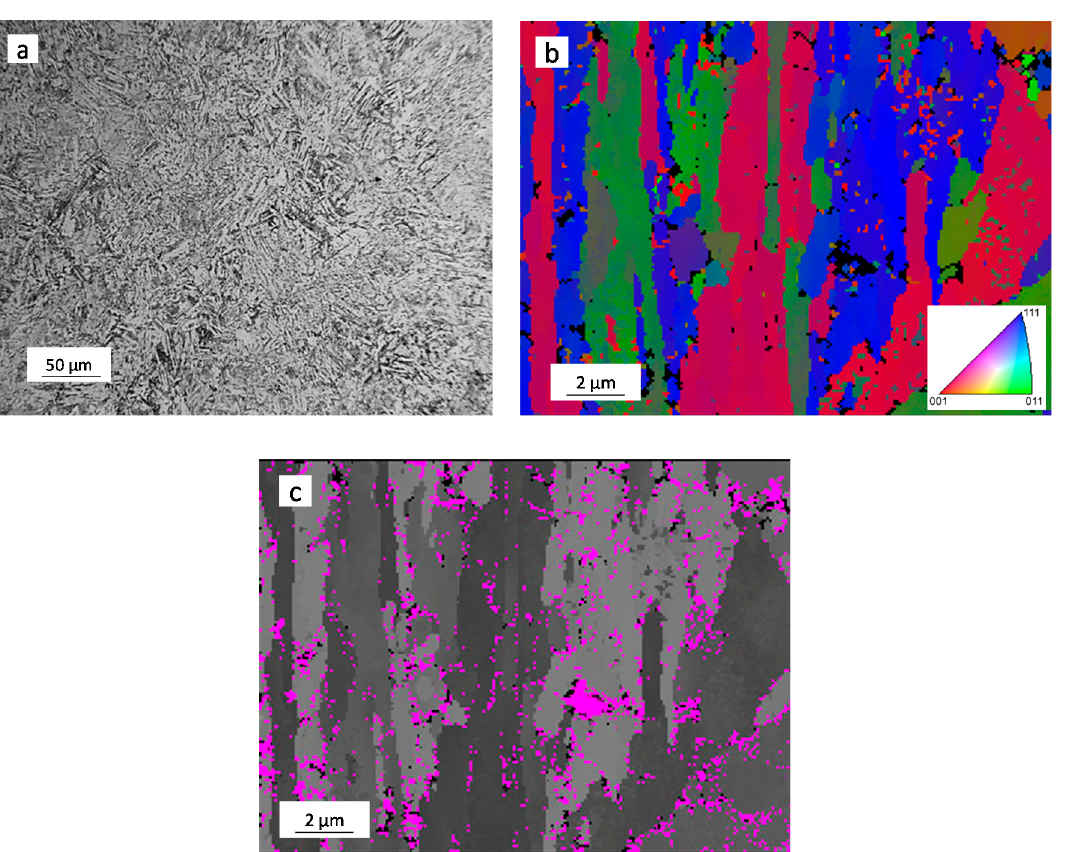
Figure 5. Representative micrographs of the solution treated sample, ( a ) revealed by optical microscopy; ( b ) EBSB orientation image; and ( c ) phase map highlighting γ -Fe phase (coloured in pink)